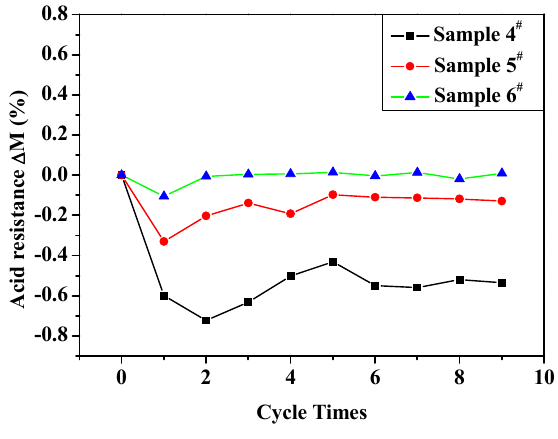
Figure 5. Acid resistance curves.